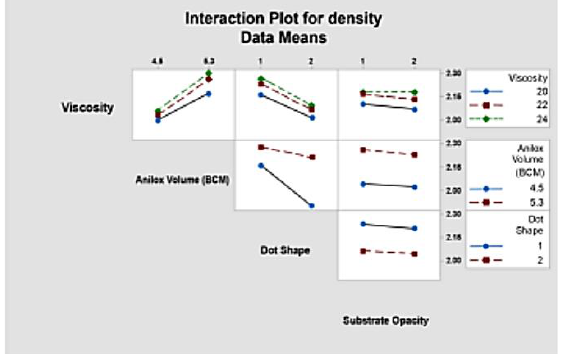
40.7mN/m that has led to higher print density.